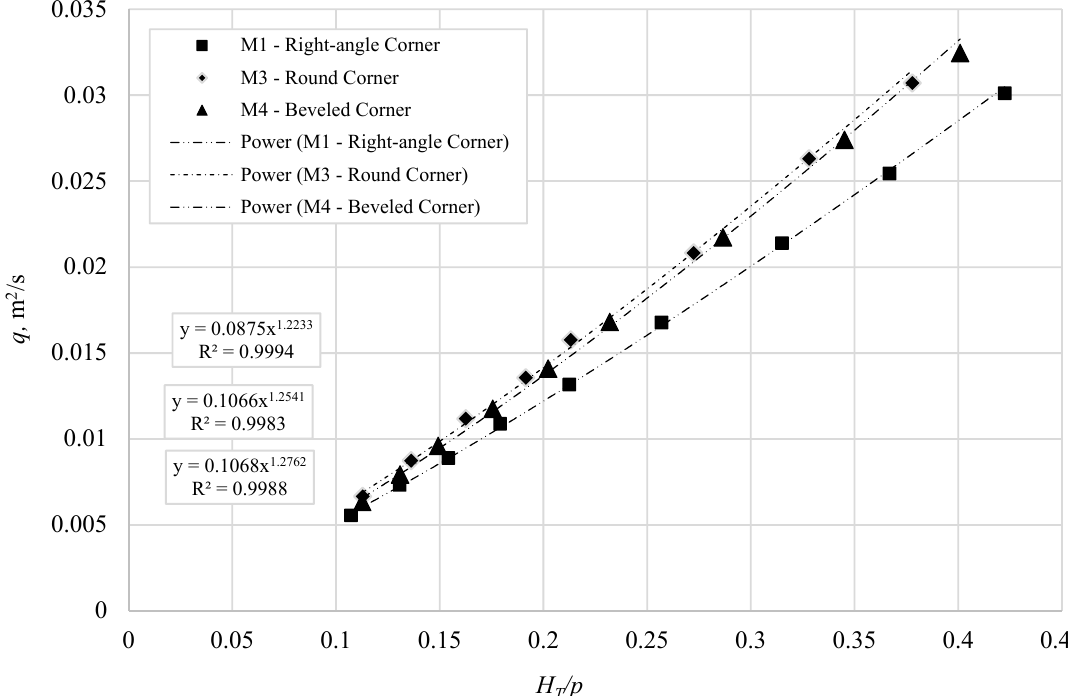
Figure 7. Comparison of discharge performance for M1, M3, and M4 models.